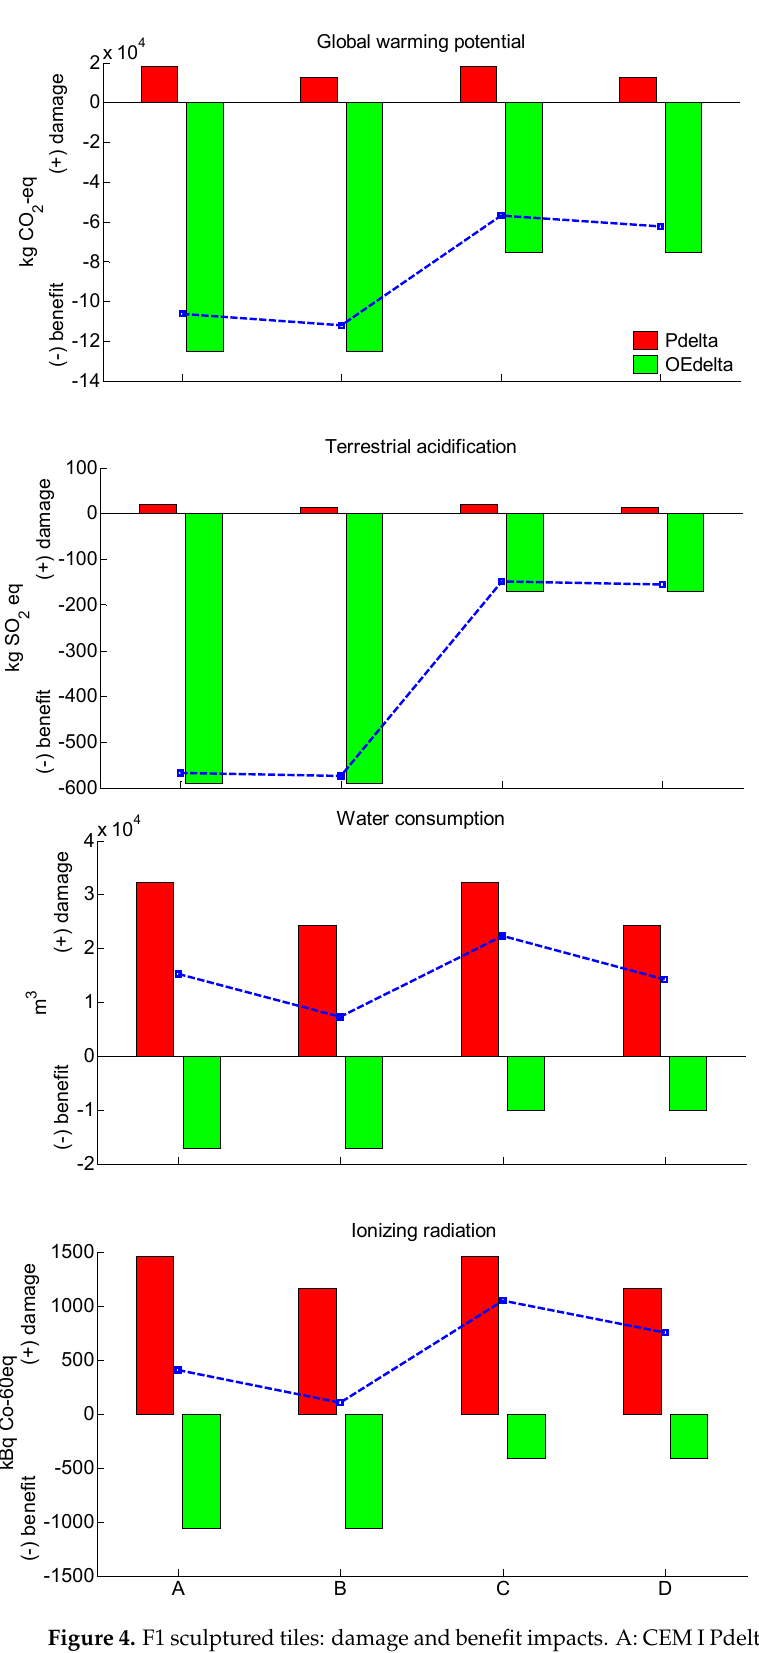
Figure 4. F1 sculptured tiles: damage and benefit impacts. A: CEM I Pdelta and 2020 OEdelta; B: CEM II Pdelta and 2020 OEdelta; C: CEM I Pdelta and 2025 OEdelta; D: CEM II Pdelta and 2025 OEdelta. Dotted line: total Pdelta + OEdelta. Evaluation was performed with ReCiPe2016 midpoint method, hierarchist (H) option.